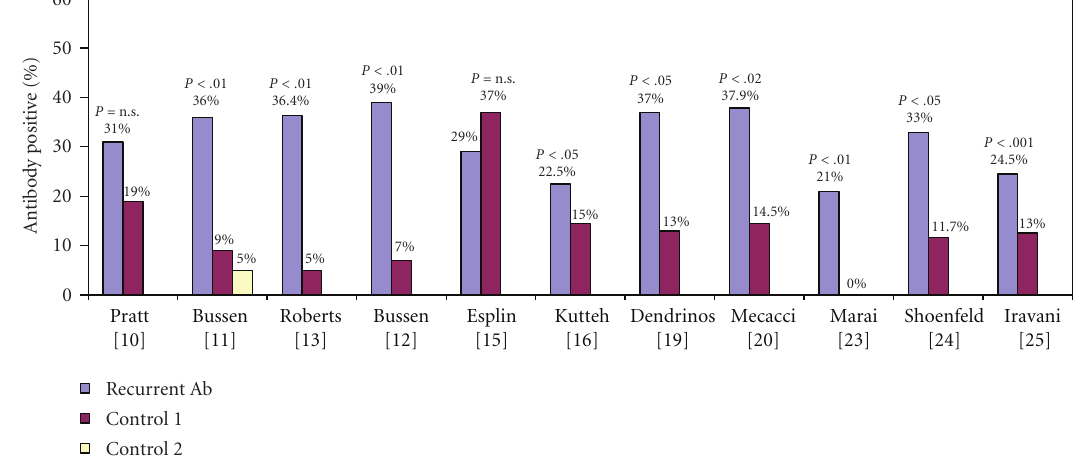
Figure 2: Percentage of thyroid antibody positivity in women with recurrent abortion (Recurrent Ab) and controls.